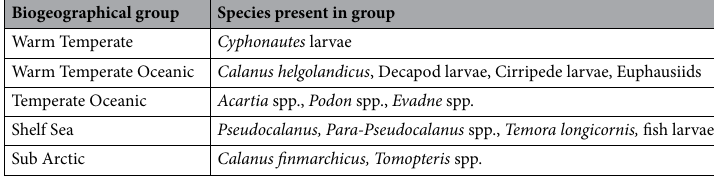
Table 1. Biogeographical zooplankton groupings following Ref. 53 used in this